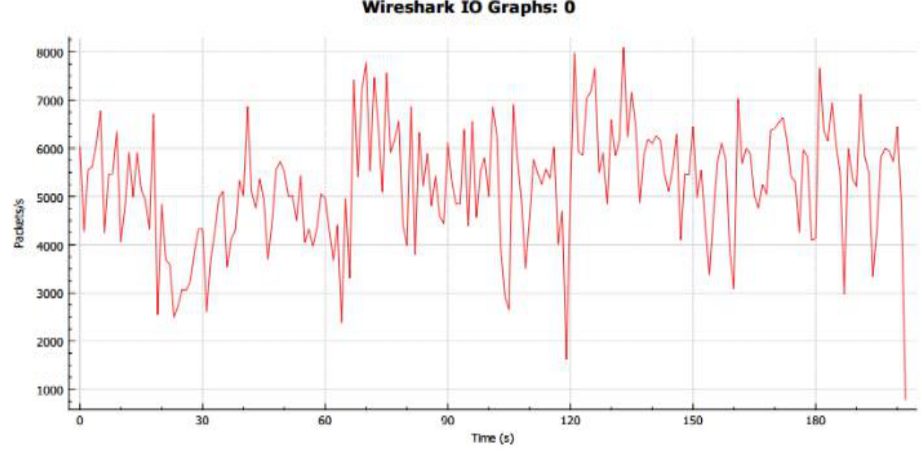
Figure 2. Traffic intensity (packet / sec) at λ =